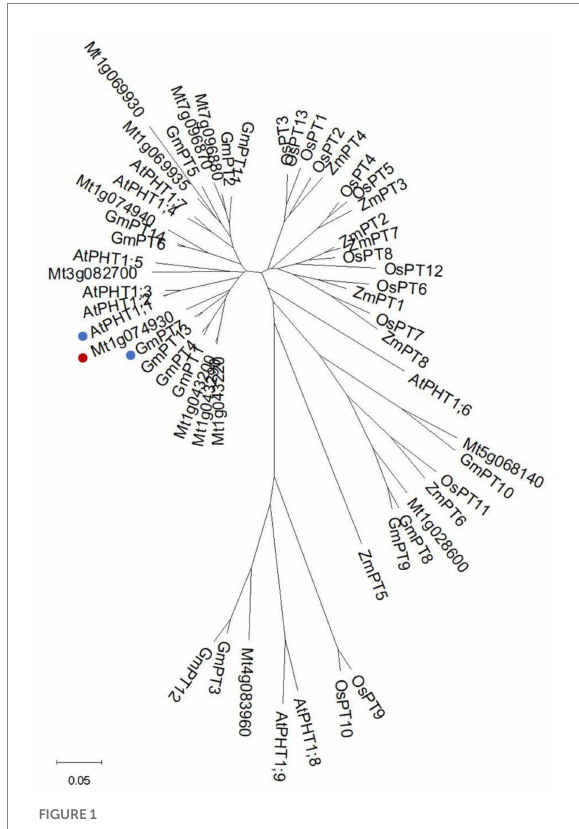
FIGURE 1 Phylogenetic analysis of PHT1s from different species. Phylogenetic tree of PHT1s from Medicago truncatula , Arabidopsis , soybean, maize, and rice. The tree was generated as described in materials and methods. Mt1g074930 (MtPT5) was labeled with a red spot. AtPHT1;1 and GmPT7 were labeled with blue spots. The bar shows 0.05 amino acid substitutions per